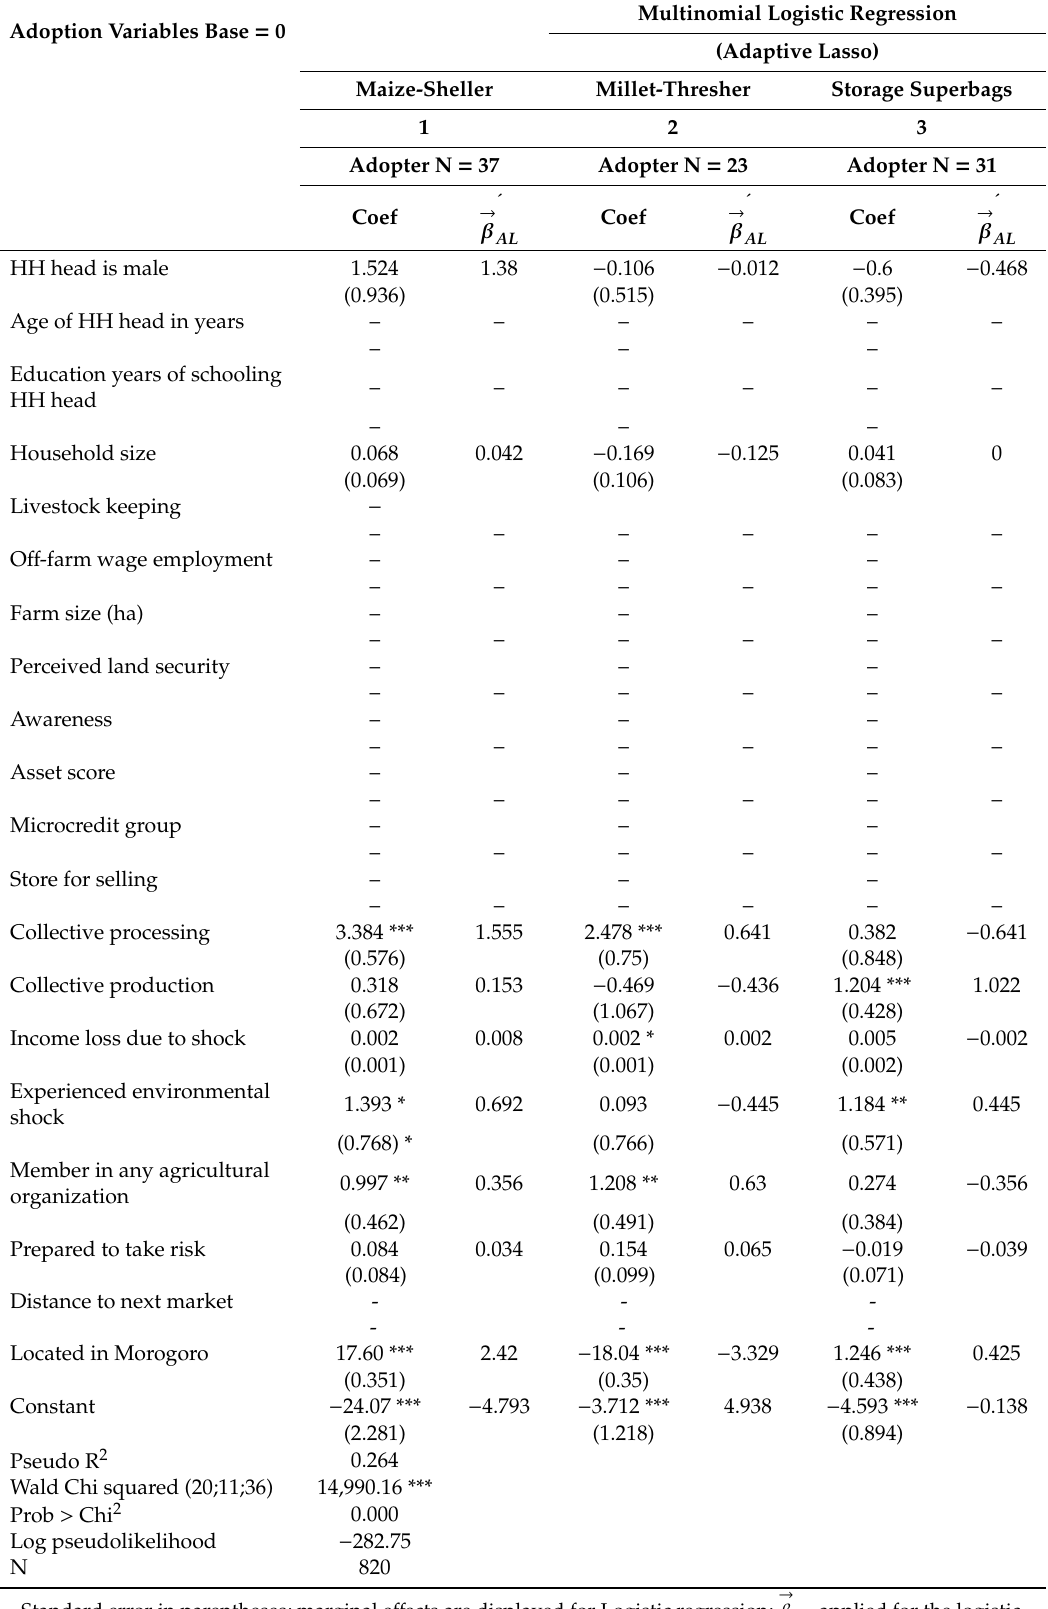
Table A5. Factors that influence the adoption decision of UPS in Tanzania—estimates from multinomial logistic regression and the adaptive